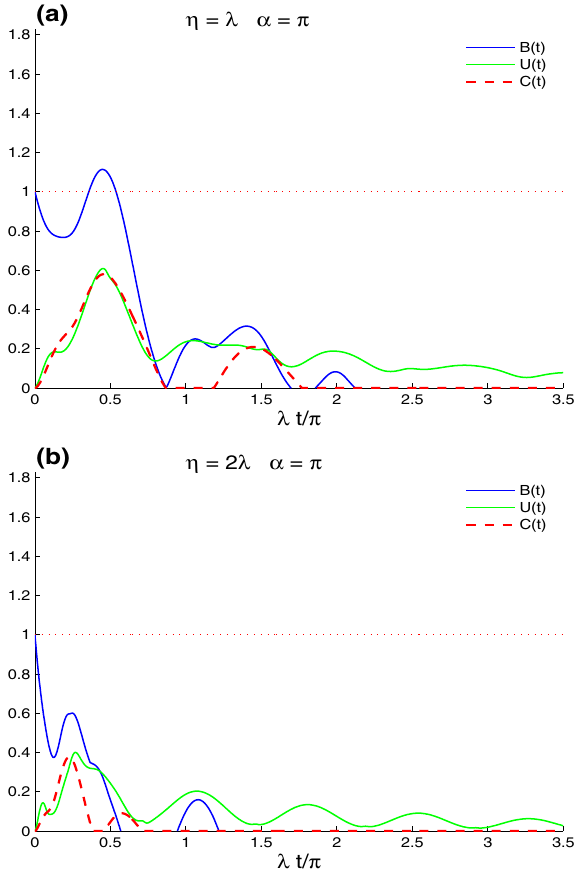
Figure 2. Dynamics of the nonlocal correlations of the Fig. 1b,c but in the presence of the decoherence 0.125 10 2 (cid:31) γ = ×